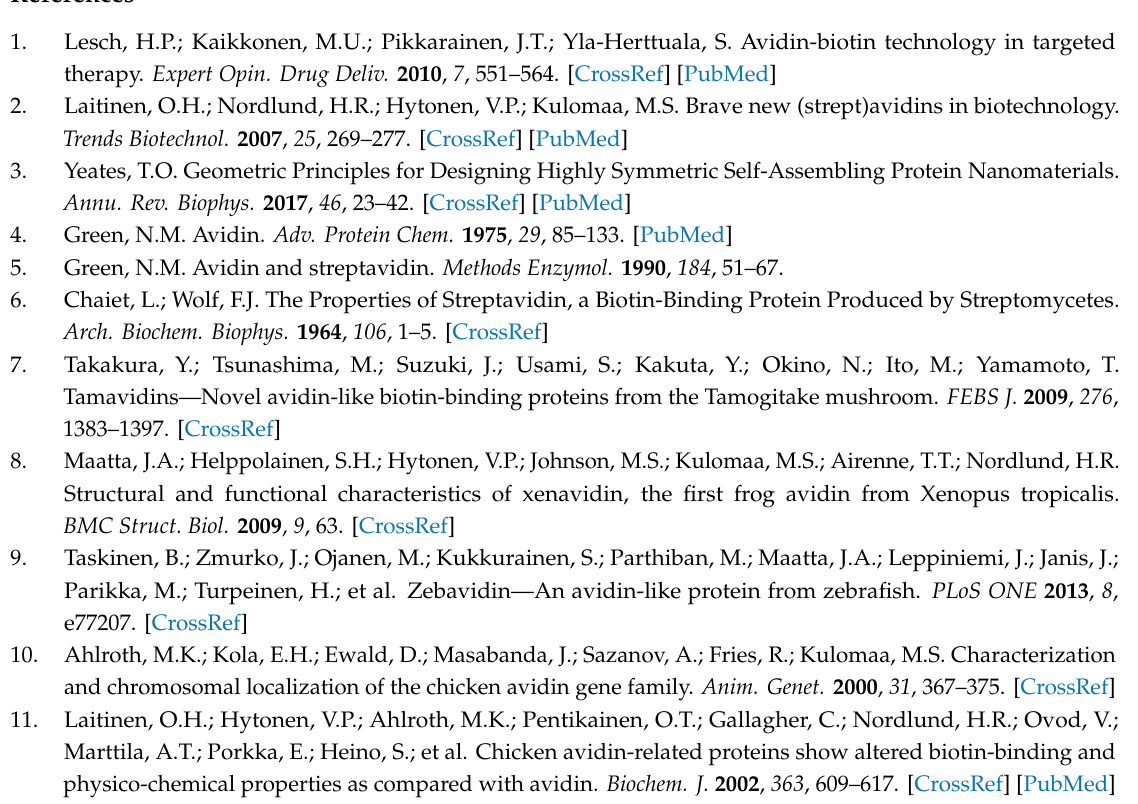
Figure S1: SPR sensorgram, Figure S2: DSF traces of P61C hoefavidin before and after crystallization and of wt